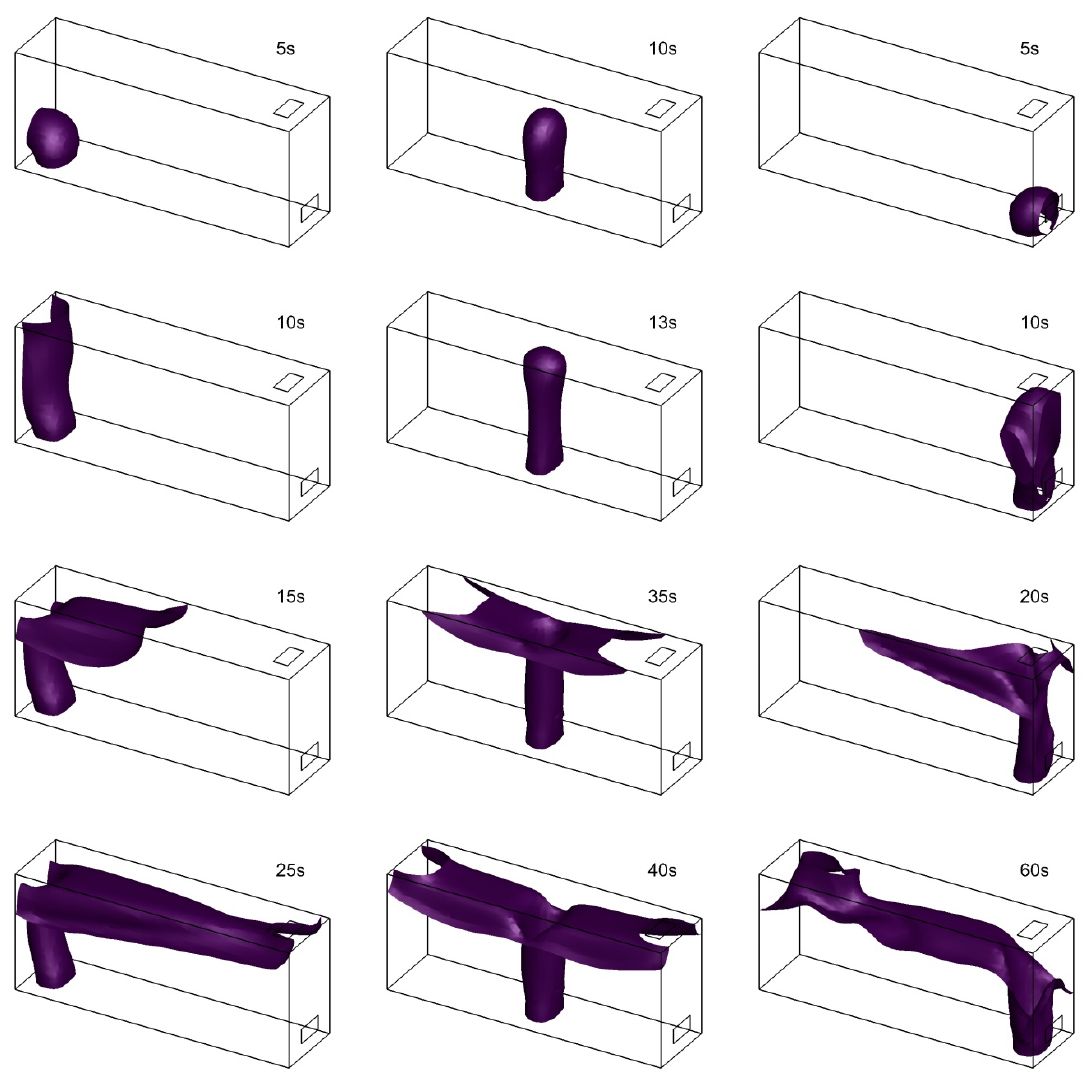
Figure 4. Iso-surface of 1% hydrogen mole fraction for Model 1 (left), Model 2 (middle), and Model 3 (right). The velocity vectors in the median z = 0.37 plane while the envelope of the iso-surfaces Like the aforementioned iso-surface of 4% mole fraction, the envelope of iso-surfaces of 1% mole fraction was rising to the ceiling and extending horizontally to the end of